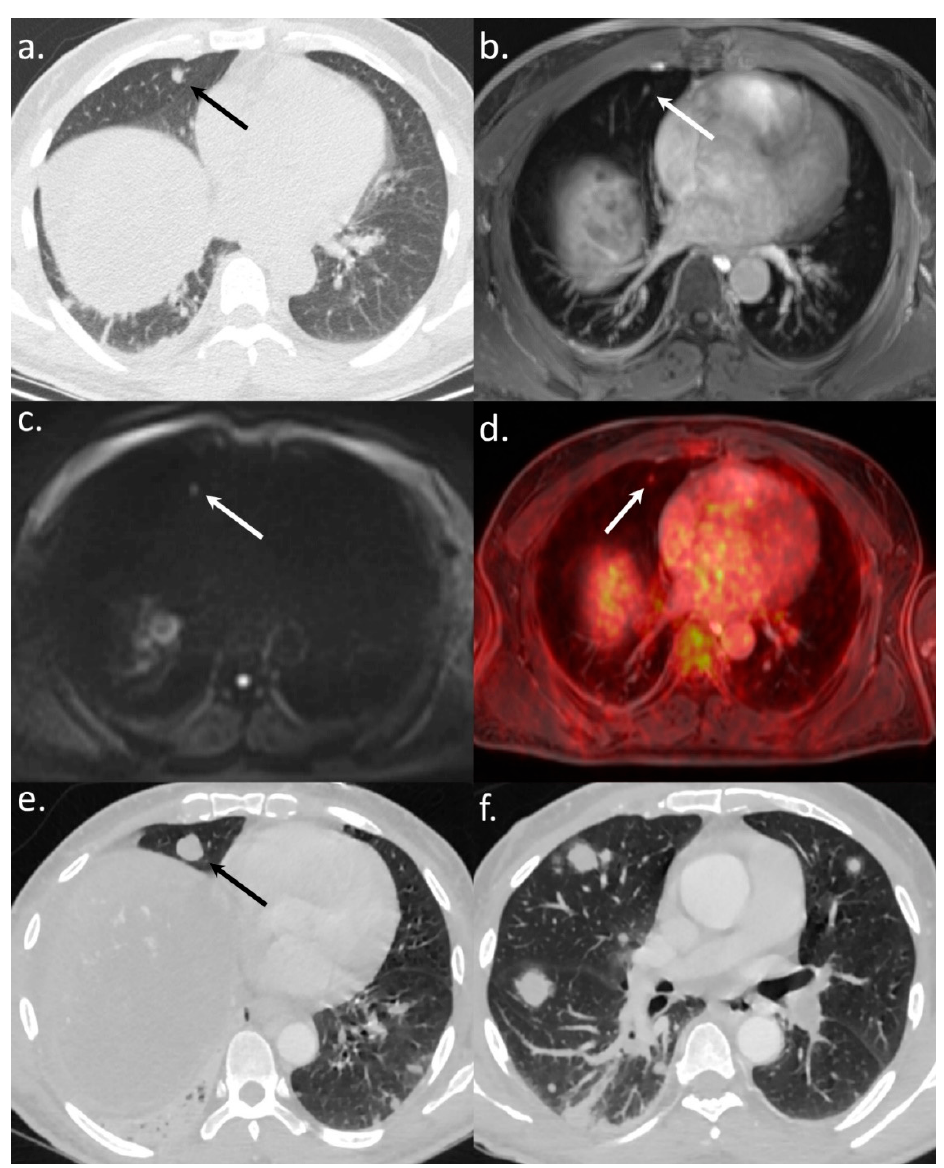
Figure 2. A 56-year-old patient referred to WB-PET/MRI before TARE. The CT-CAP ( a ) showed a solitary rounded 7 mm-size lung nodule (arrows). The WB-PET/MRI confirmed an infracentimetric lung nodule visible on morphologic sequences (T1-weighted after gadolinium injection) ( b ) with hyperintensity on b800 s/mm² DWI ( c ) and 18 F-FDG hypermetabolism ( d ) leading to the diagnosis of lung metastasis. The followup CT scan ( e , f ) performed three months after the WB-PET/MRI showed a significant progression of the number and size of lung nodules, confirming the metastatic status.